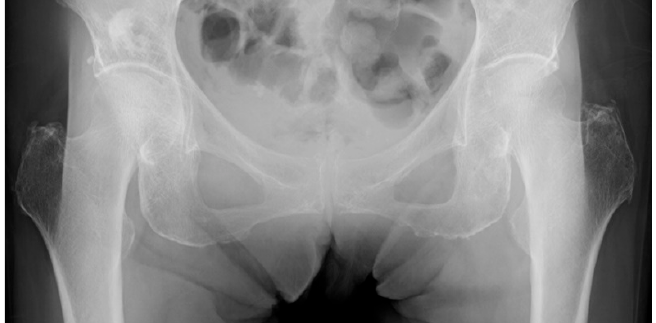
Figure 1. Preoperative anteroposterior radiograph showing a left nondisplaced femoral neck fracture. The patient was a 71 year old woman of 140 cm height and 34 kg weight (body mass index 17.3 kg/m 2 ). We did not exclude the images that were difficult to measure due to the influence of soft tissues or radiation dose.